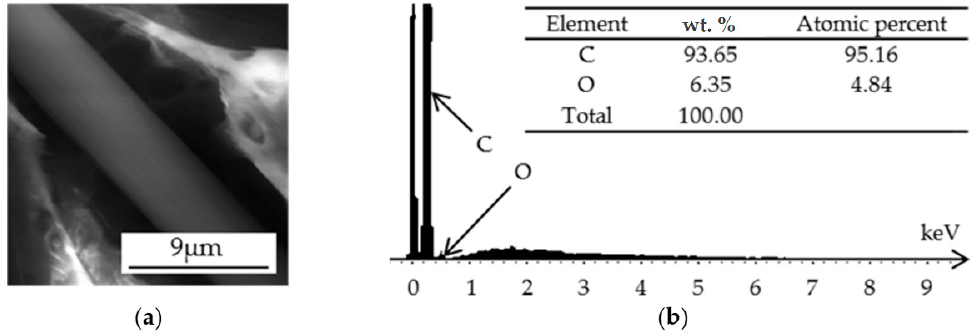
Figure 6. Reinforced PA6 with 30 wt. % short-carbon fiber: ( a ) SEM; ( b ) XRF spectra.